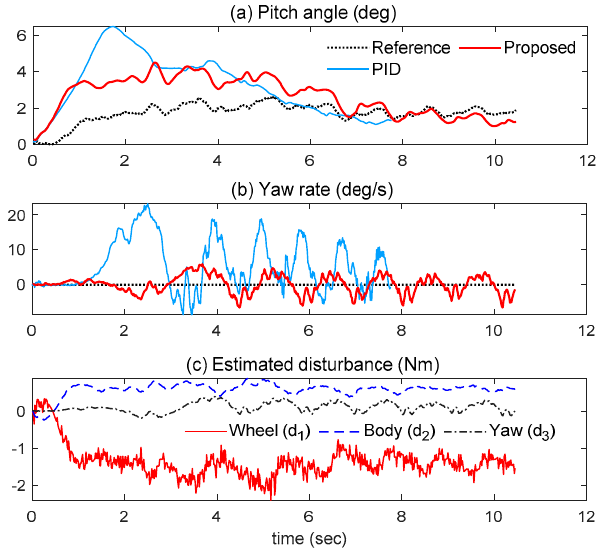
Figure 13. Effect of the lateral eccentricity.